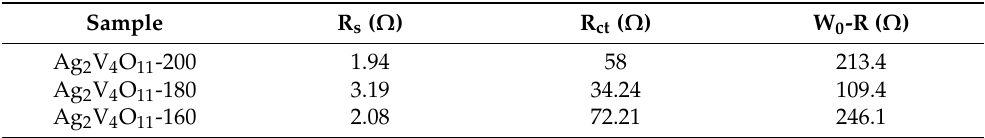
Table 2. Parameters of the equivalent circuit